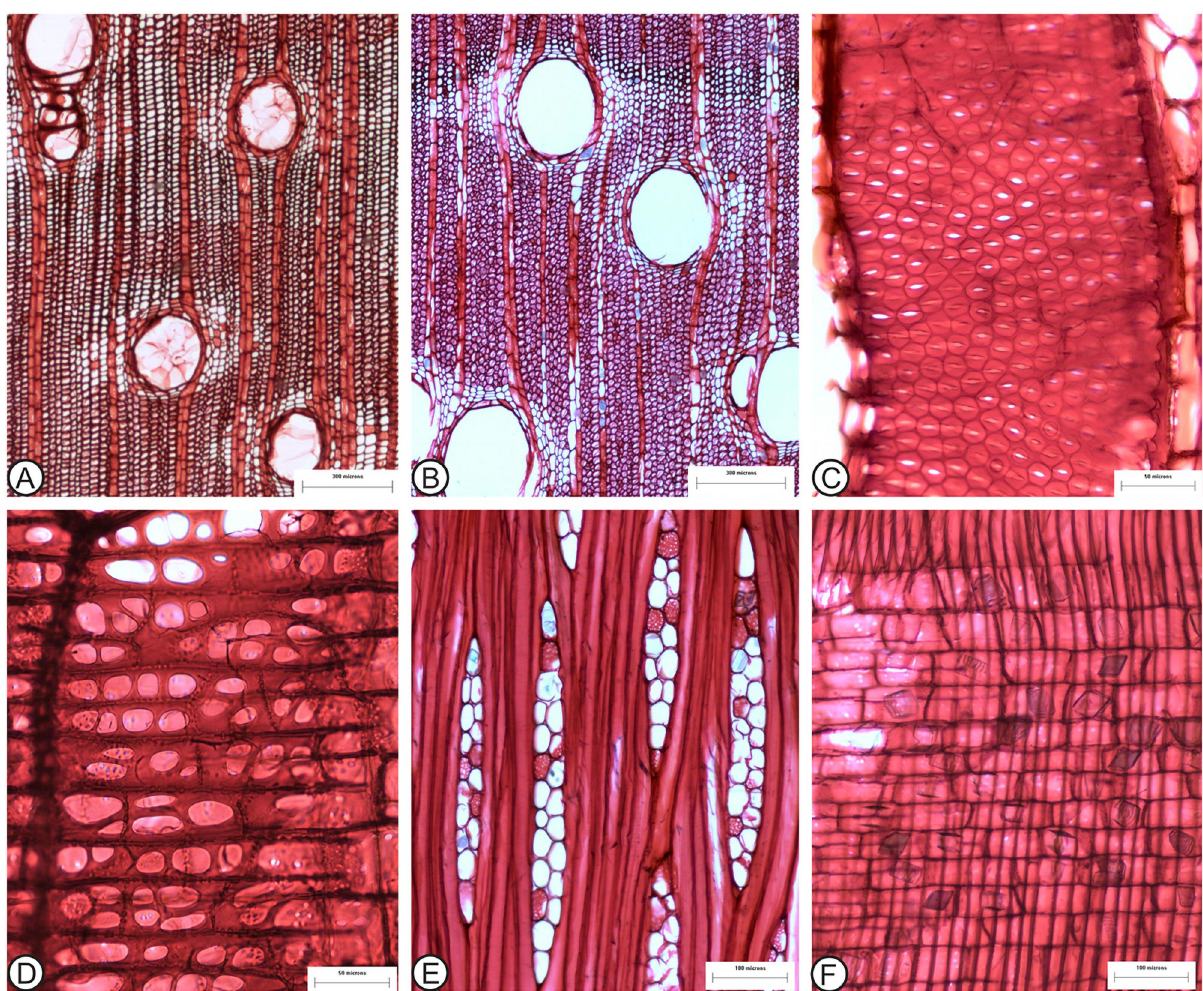
Fig 4. Anacardium excelsum wood anatomy. A, C, D, F MAD4433; B, E, MAD11551 (A) Growth ring boundaries absent, wood diffuse-porous (TS). (B) Large vessels; lozenge-aliform parenchyma (TS). (C) Intervessel pitting alternate, large, and polygonal (TLS). (D) Vessel-ray pits with much reduced borders, horizontally elongated and in palisade (RLS). (E) Rays 1–2 seriate, non septate fibers (TLS). (F) Rays composed of upright and square cells with abundant large rhomboidal crystals (RLS).